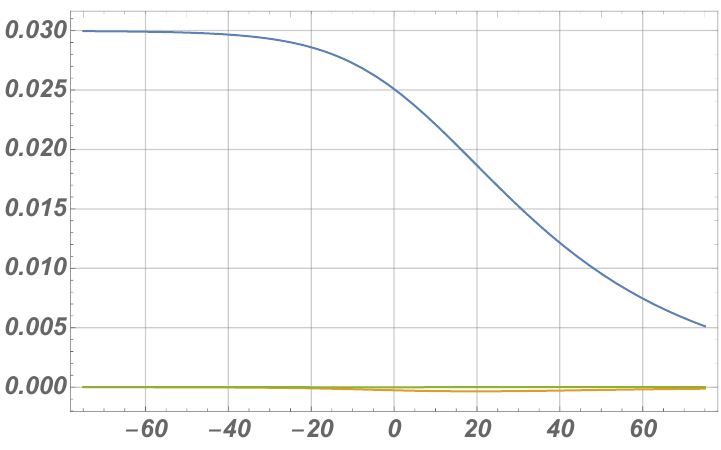
Figure 6 . Plot of (cid:27) ( t ) and its time derivatives vs. t for (cid:3) = 11 ; m i = 0 : 03 ; m f = 0 : 6 ; (cid:14)t = 25. The blue curve is (cid:27) ( t ), while the green and the orange are the (cid:12)rst and second derivatives